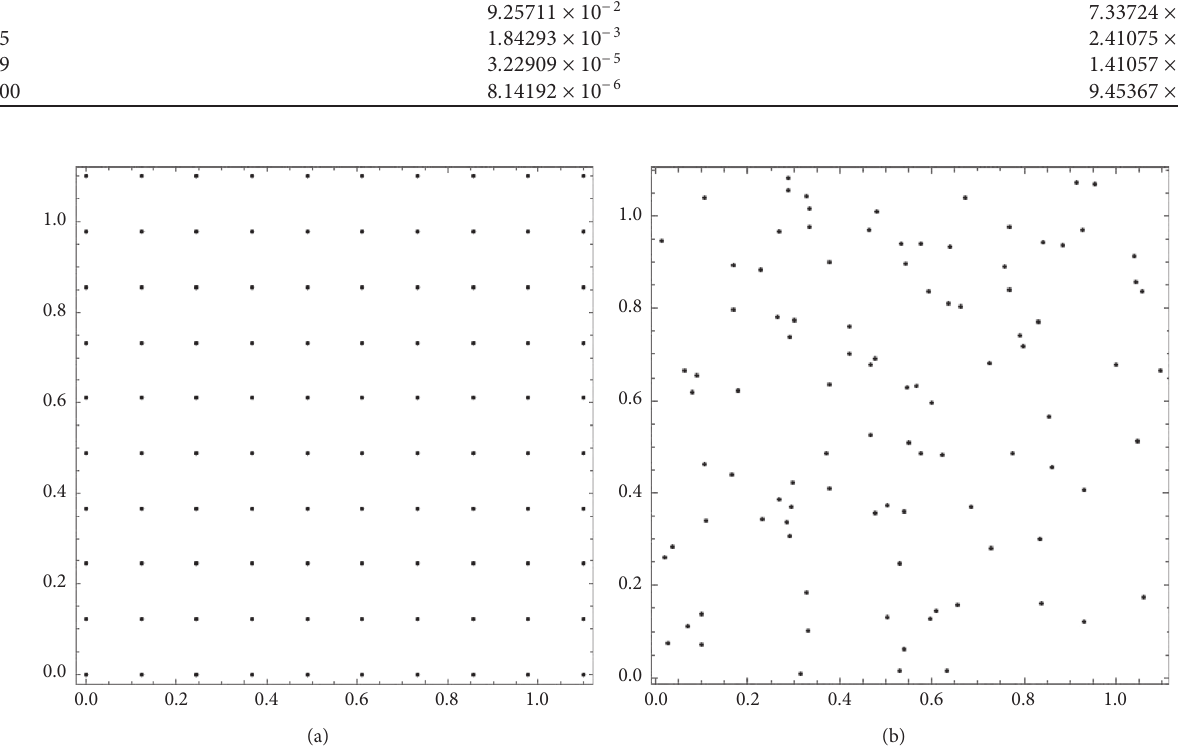
Figure 5: (a) The mesh points. (b) The meshless points. There are 100 points for interpolation.